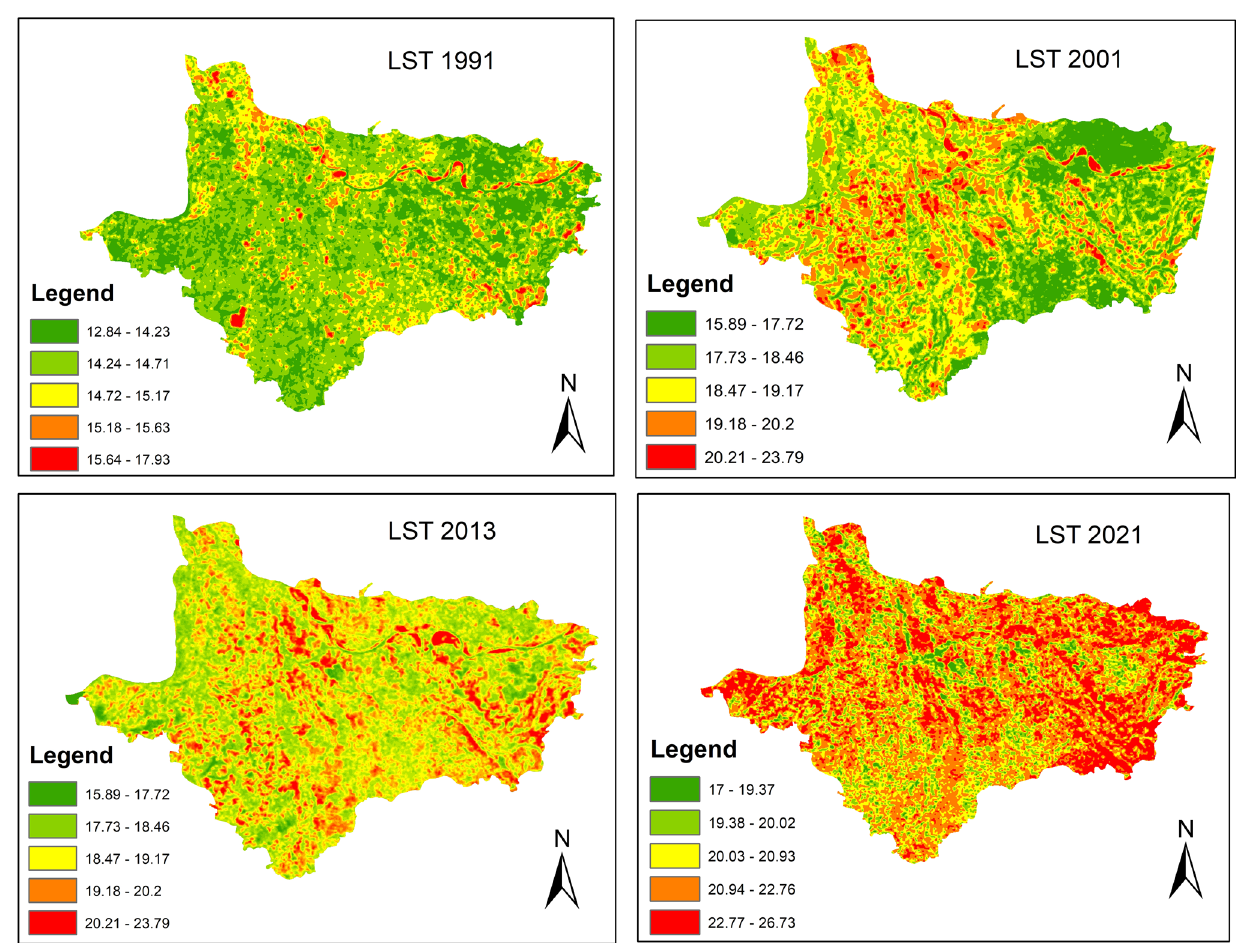
Fig. 9 Land surface temperature (LST) changes during study period (1991–2021)